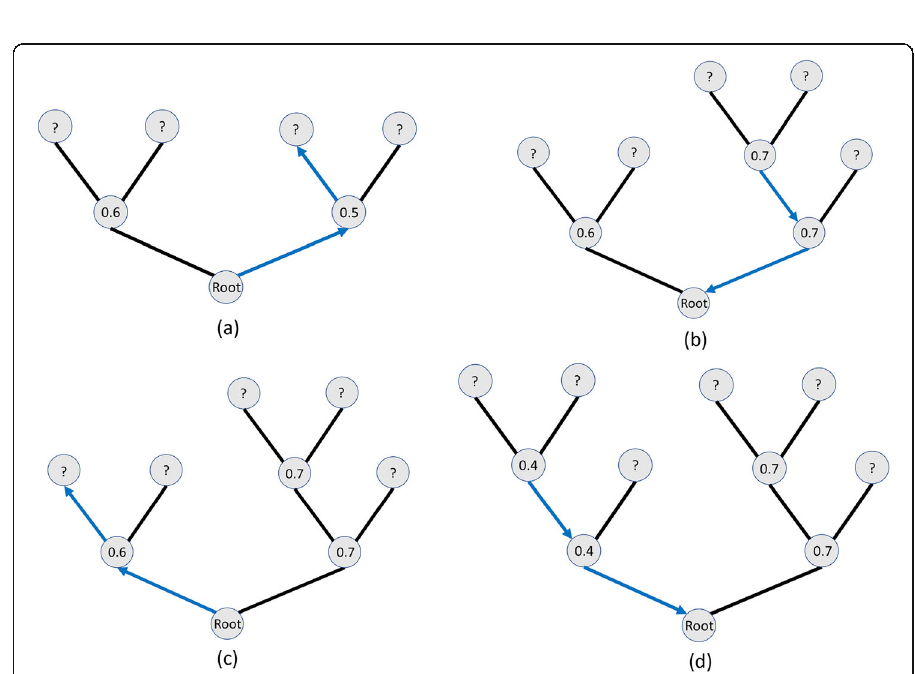
Fig. 6 Exemplification of the MCTS algorithm with two available actions per discrete time step